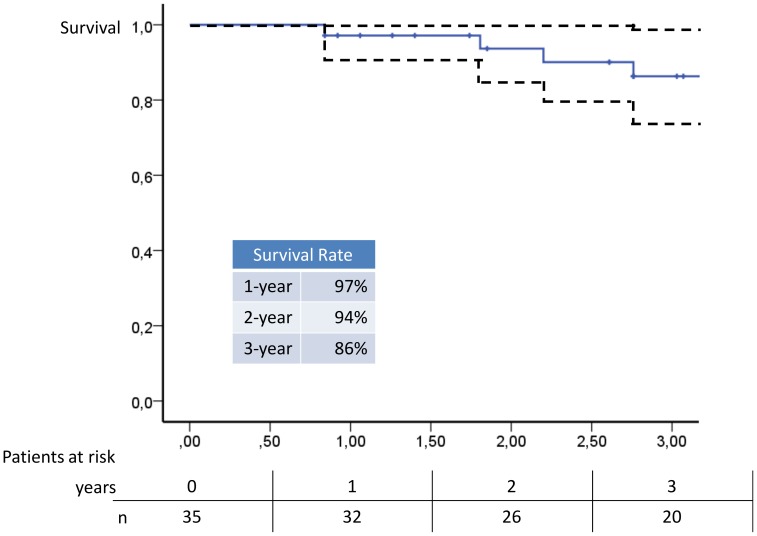
Survival by Kaplan Meier Analysis.Within a follow-up period of median 36.4 months (interquartile range 26.6–46.6 months) 6 patients deceased, 4 due to PH. One patient died due to lung cancer >4 years after baseline. In one patient cause of death remained unknown. The straight line indicates overall survival, with 97% after 1-year, 94% after 2-years and 86% after 3 years. The dashed line indicates 95% Confidence interval.